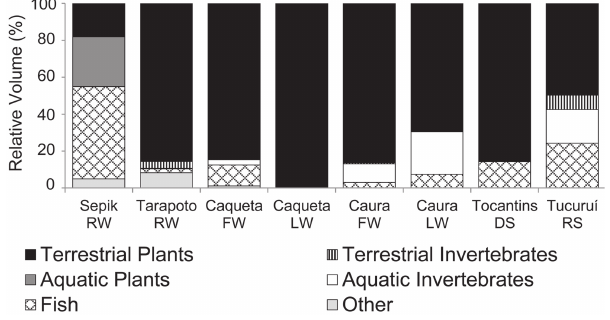
Fig. 2. Comparison of the relative contribution of food